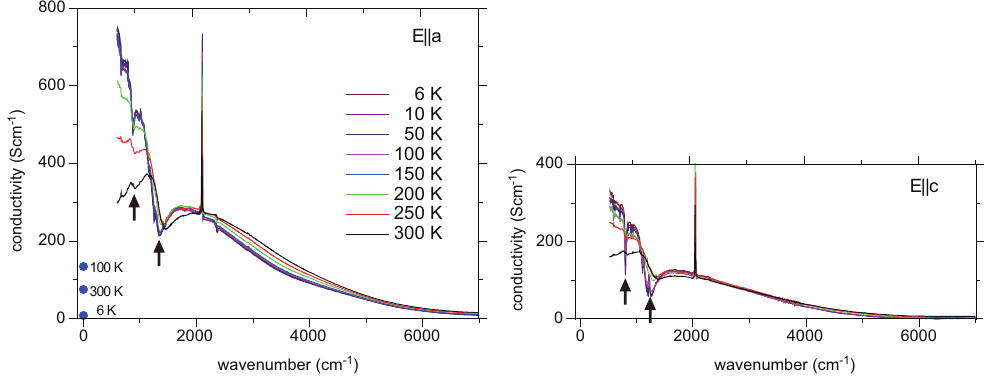
Figure 17. Optical conductivity of θ -(BEDT-TTF) the bottom panel show the dc conductivity values. The arrows show the vibronic modes appearing as dips. The color of the E|| c spectrum denotes the same temperature as that of the E|| a